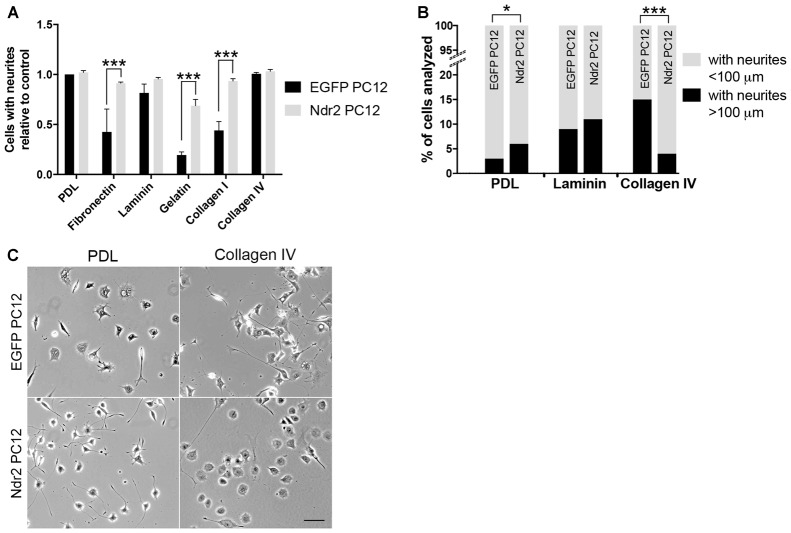
Substrate-specific modulation of neurite outgrowth through Nuclear Dbf2-related 2 (Ndr2). (A) The proportion of cells with neurites is increased on fibronectin, gelatin and collagen I in Ndr2 PC12 cells, while the more permissive substrates poly-D-lysine (PDL), laminin and collagen IV show generally high neurite formation in both Ndr2 rat pheochromocytoma cells (PC12) and EGFP PC12 control cells (mean + SEM, N = 3, two-way ANOVA genotype × substrate interaction: F(5,24) = 4.575, p = 0.0045). (B) In line with a generally increased neurite growth, the Ndr2 PC12 cells also show an increase in the proportion of cells bearing long neurites (>100 μm) on PDL substrate (X2(1) = 4.276, p < 0.05). However, the Ndr2 PC12 cells fail to show the enhancement of neurite extension on collagen IV substrate that is evident in EGFP PC12 controls (X2(1) = 81.45, p < 0.001). (C) Microscopic images of EGFP PC12 and Ndr2 PC12 cells on PDL and Collagen IV substrates displaying the differences in neurite numbers and morphologies. *p < 0.05; ***p < 0.001. Scale bars: 100 μm.